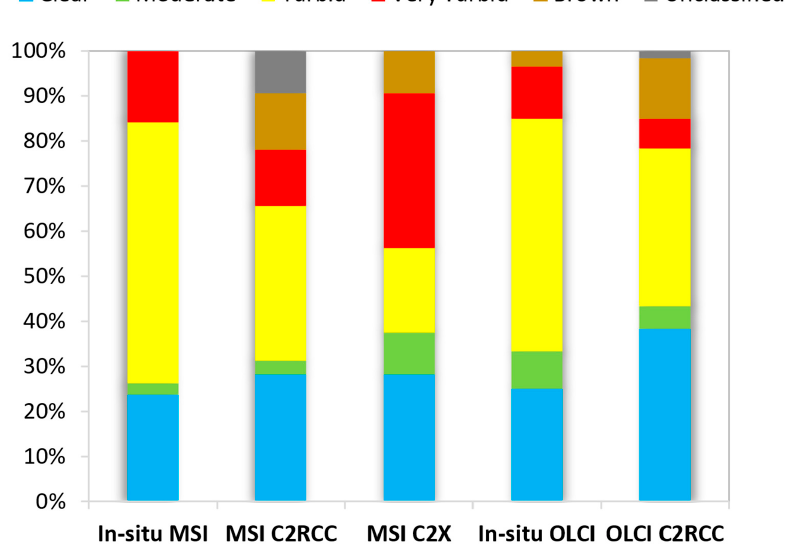
Figure 4. Distribution of the optical water type (OWT) classes. MSI in-situ, MSI C2RCC and C2X OWTs are for 32 match-ups. OLCI in-situ and OLCI C2RCC OWTs are for 60 match-ups.